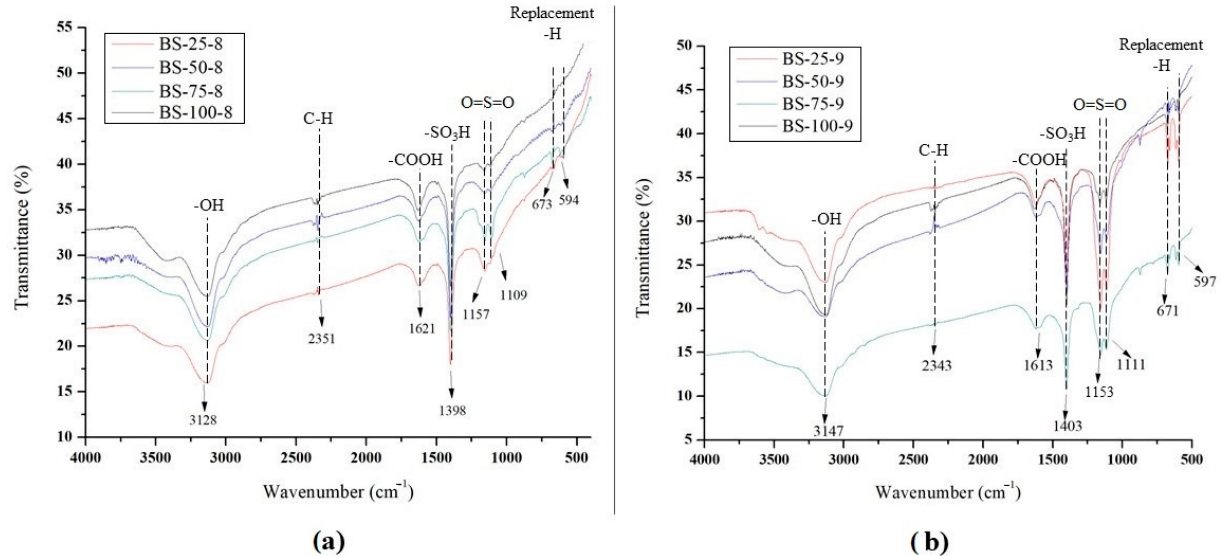
Figure 5. FT-IR of the functionalized biochars obtained at ( a ) 800 °C and ( b ) 900 °C. In this sense, the signal at 1398 cm − 1 is likely due to the superposition of -COOH and stretching of -SO 3 H, according to different reports [29,30]. Sulfonation is corroborated by the presence of the signal at 1109 cm − 1 , which is associated with O=S=O symmetric and